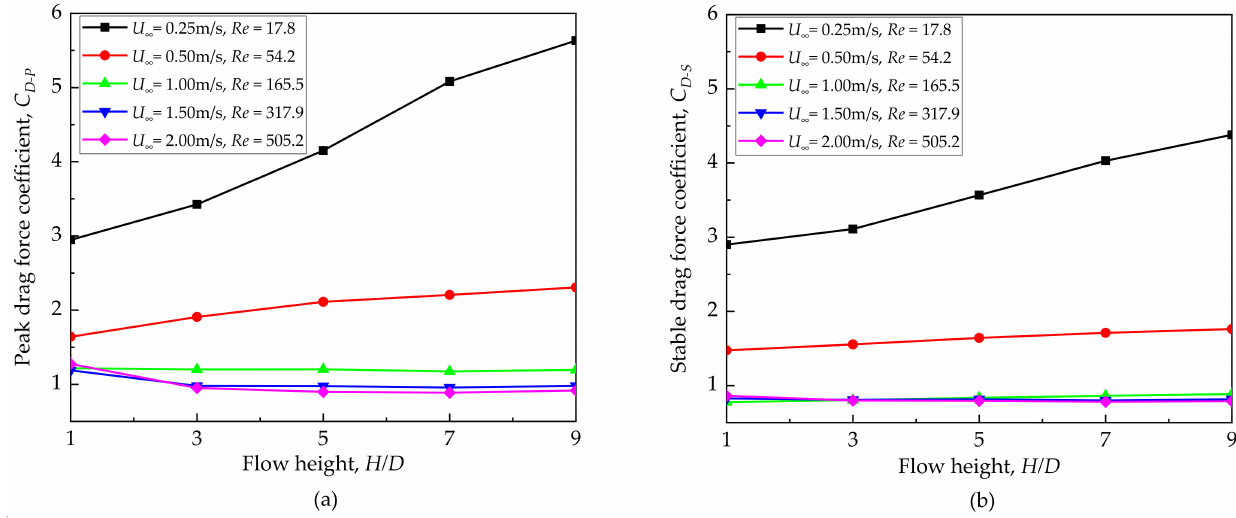
Figure 9. Relationship between CD and H/D considering different Re non-Newtonian ( U ∞ ). ( a ) Peak drag force coefficient; and ( b ) stable drag force